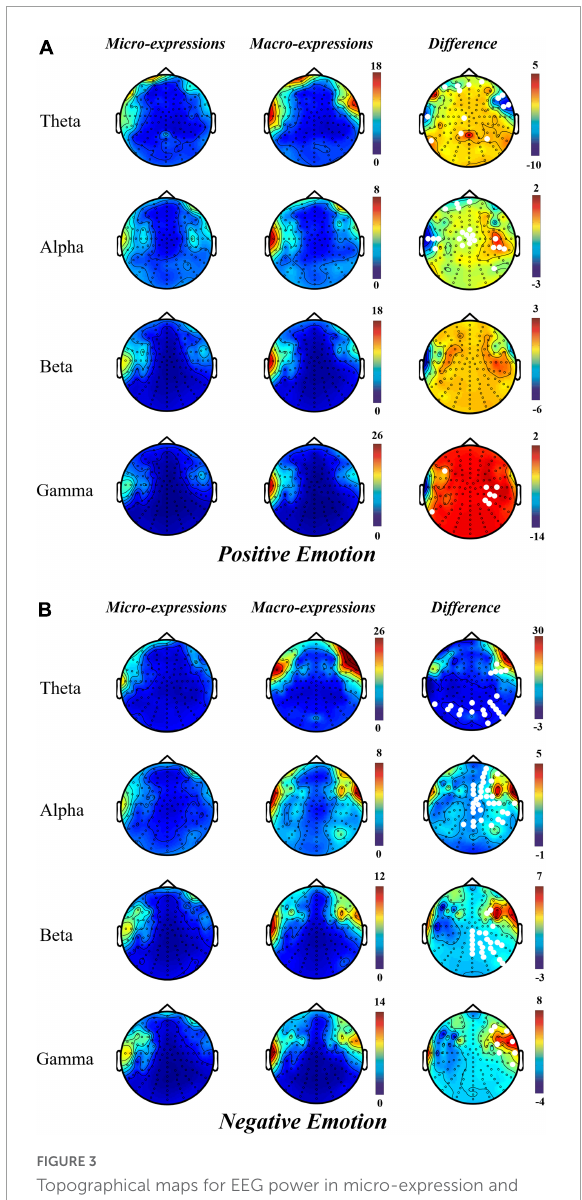
FIGURE3 Topographical maps for EEG power in micro-expression and macro-expression from theta, alpha, beta and gamma bands in (A) Positive emotion and (Micro-expression minus Macro-expression) (B) Negative emotion (Macro-expression minus Micro-expression). The white dots on the difference graph are the electrode points with significant difference between the power of micro-expression and macro-expression.